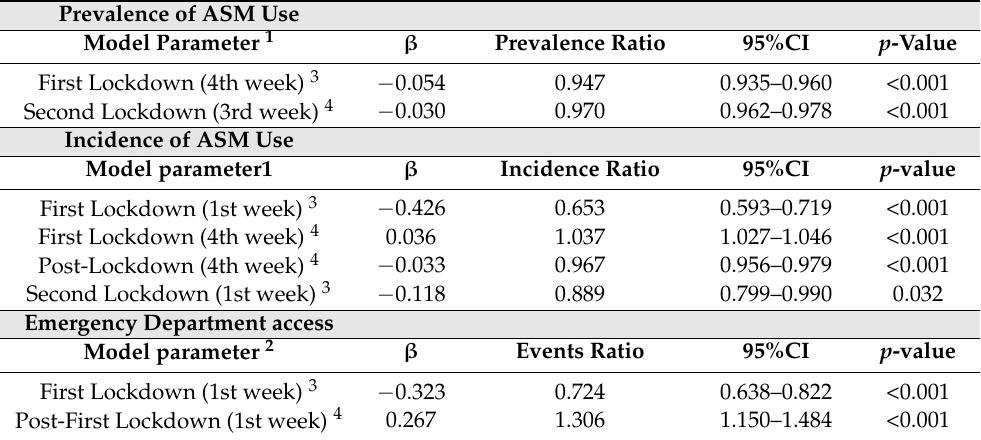
Table 1. Time series analysis of anti-seizure medication (ASM) use and emergency department access across different time segments: Pre-Lockdown, First Lockdown, Post-Lockdown and Second